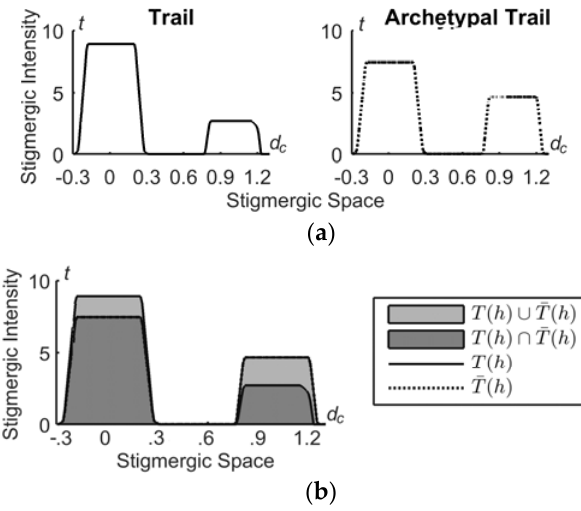
Figure 8. ( a ) Two trails and ( b ) their similarity.